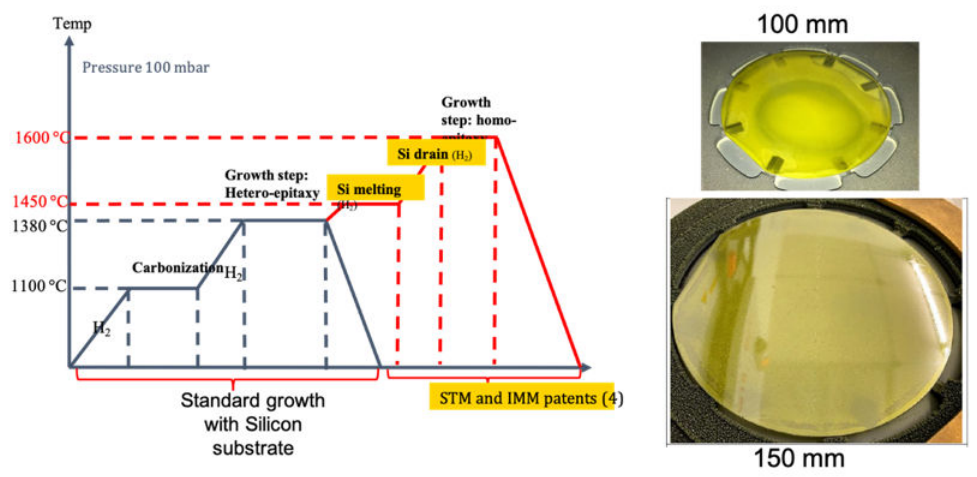
Figure 24. Schematic of the new process for CVD bulk growth (left). 3C-SiC wafers with the dimensions of 100 mm and 150 mm grown with the new process (right, adapted from Reference